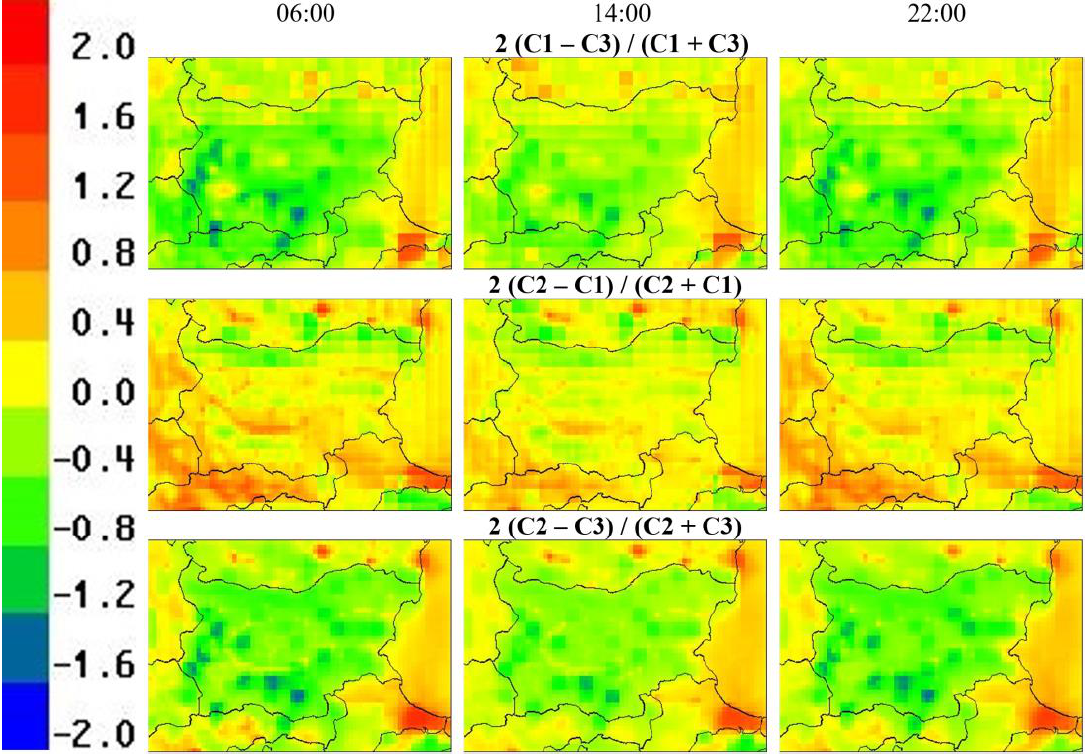
Figure 5. Annually averaged relative differences of the surface concentrations of PM 2.5 between cases C1 and C3, C2 and C1, C2 and C3 respectively.